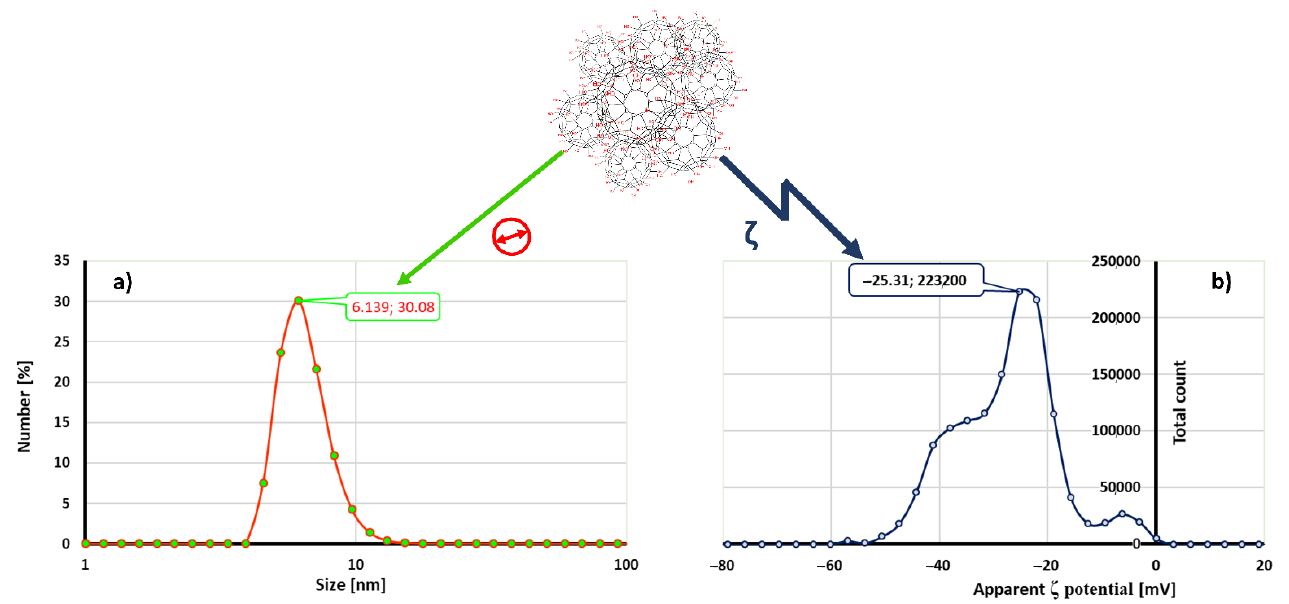
Figure 1. Fullerol C 60 (OH) 24 aqueous nanoparticles solution (c = 10 mg mL − 1 ) size distribution by number ( a ) and apparent zeta potential (ζ) ( b ). Data represent one selected result out of three measurements with similar obtained values of mean hydrodynamic radius ( a ) and surface charge ( b ).